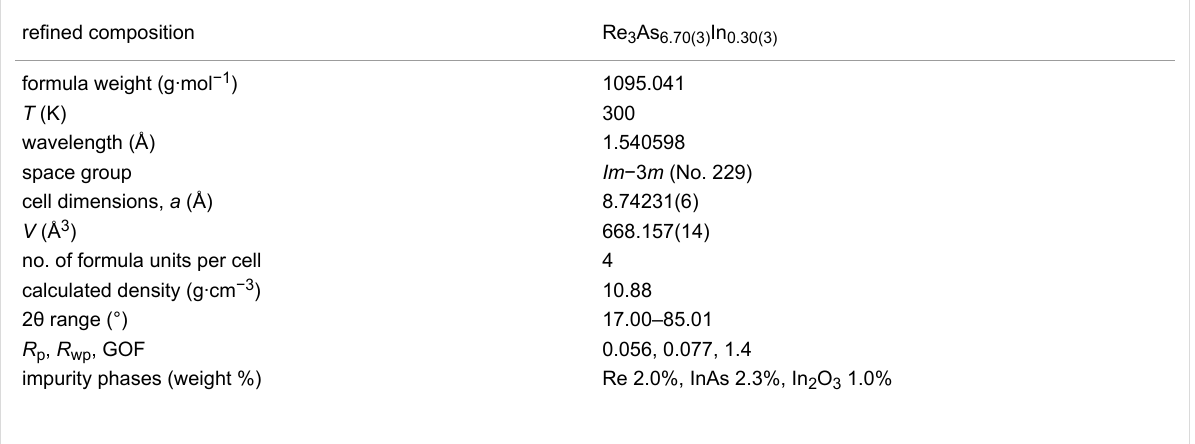
Table 1: Crystallographic data from the powder diffraction experiment for S1 .